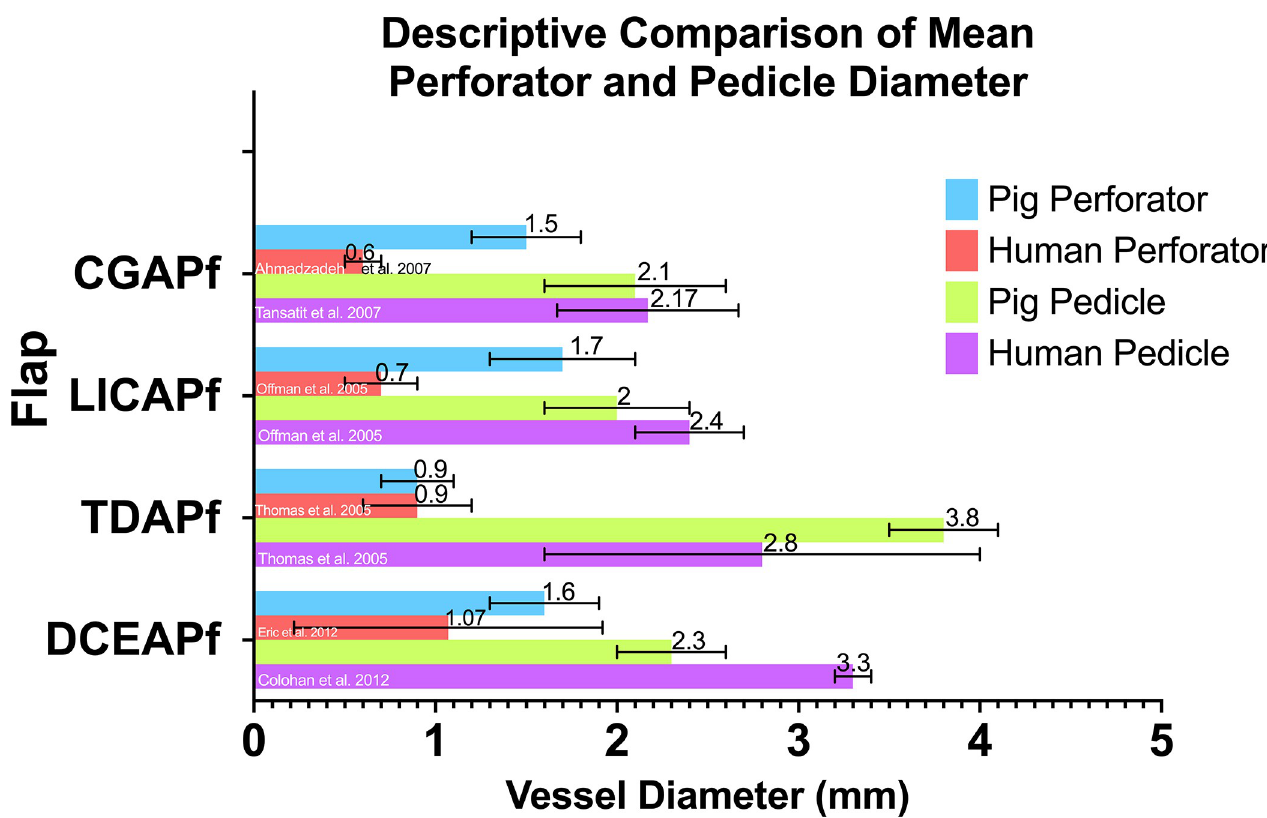
Fig 5. Descriptive comparison of perforator and pedicle diameter for the pig models and human counterpart for each flap type. DCAPf has no human correspondent.